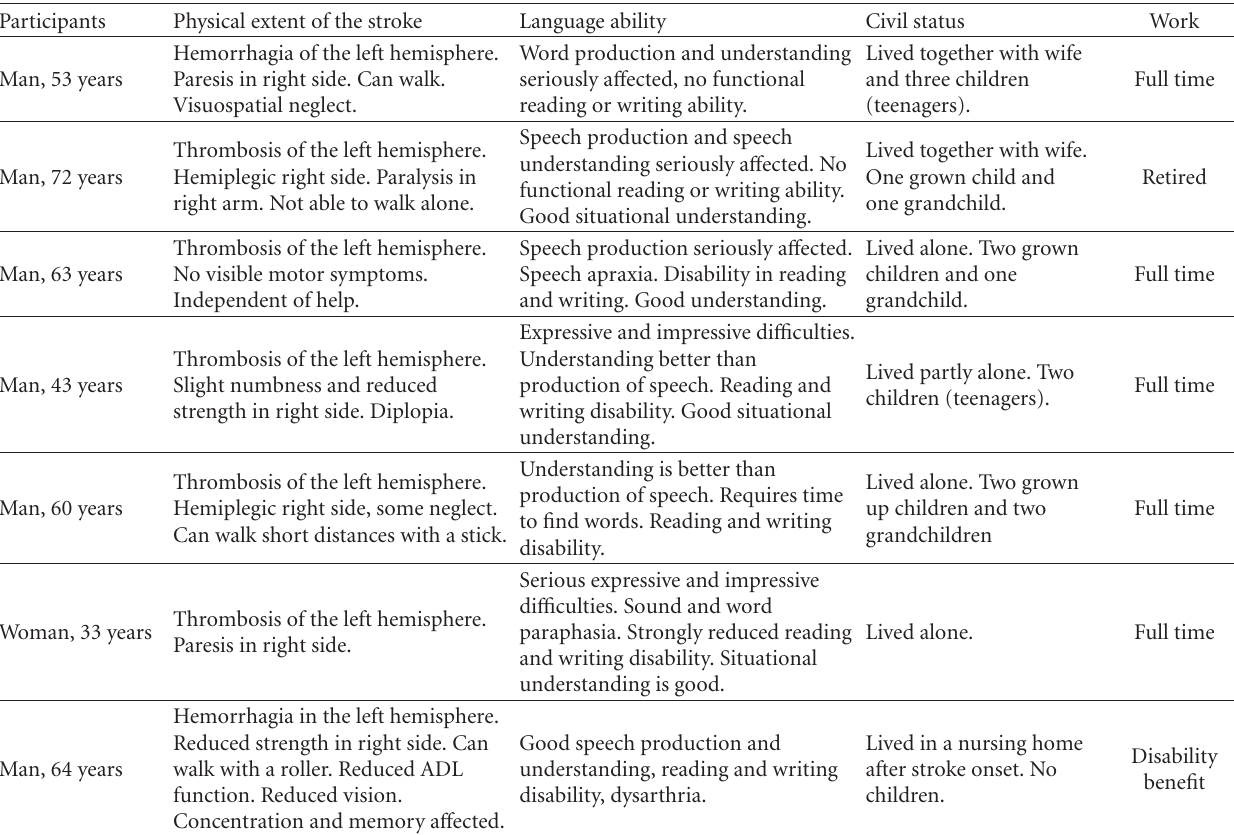
Table 2: Medical and demographic information describing the